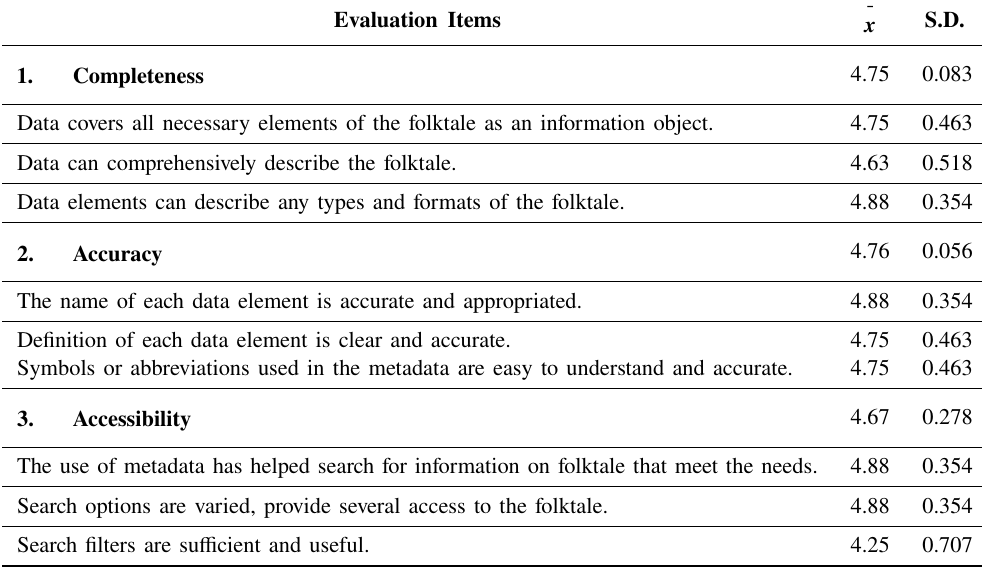
Table 2. Evaluation of the developed